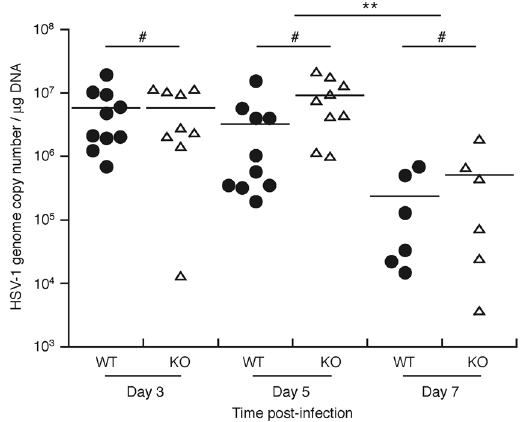
Figure 6. Primary skin infection site viral genome copy numbers are indistinguishable in wild type and IL-36 β KO mice. Wild type (black circles) and IL-36 β − / − (open triangles) mice were infected with HSV-1 on the flank skin as described in Fig. 2. The center of primary infection sites were collected with 4 mm punch biopsy tools at the indicated time-points. Viral genome copy numbers were determined by QPCR. Each symbol represents a single mouse. ** p < 0.01; # p > 0.05.